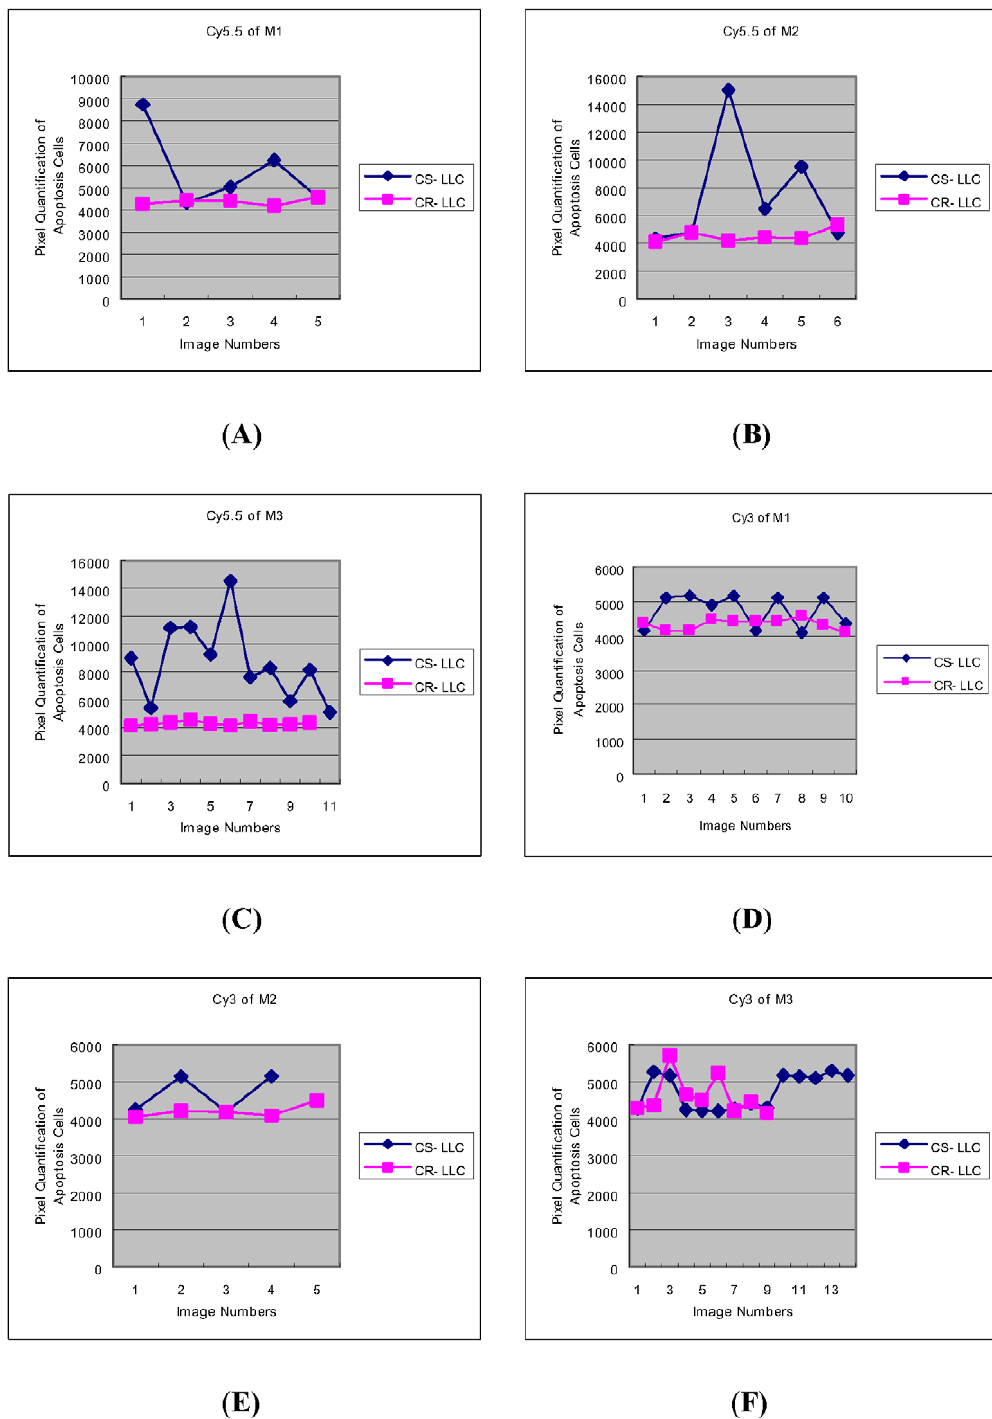
Fig. 3. Average histological appearance of the pixels above threshold, according to the methodology presented, for each section studied for CS-LLC ( 2 ) and CR-LLC ( 1 ) tumors. Appearance of (A) Cy5.5 of M1, (B) Cy5.5 of M2, (C) Cy5.5 of M3, (D) Cy3 of M1, (E) Cy3 of M2 and (F) Cy3 of M3